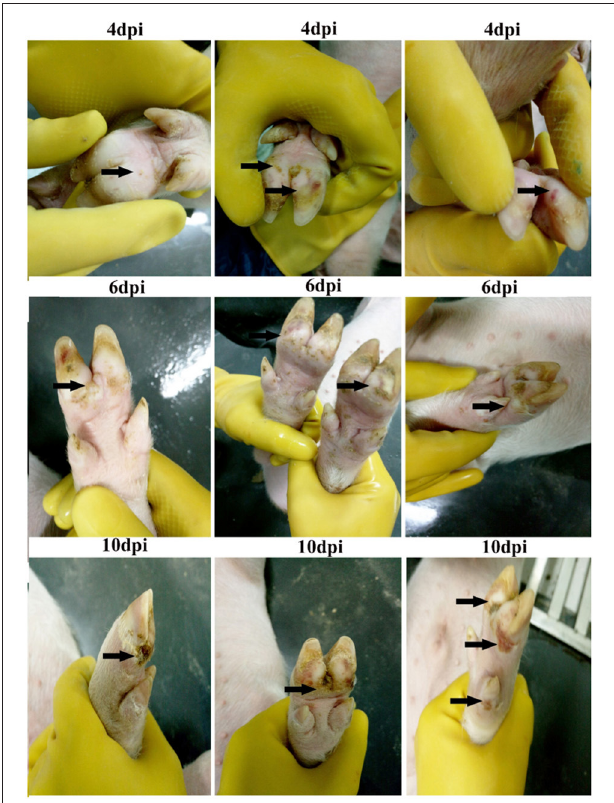
FIGURE 2 | Progression of Senecavirus A (SVA)-induced vesicular disease on hooves. Red spots were firstly observed on hooves [4 days post-infection (dpi)] and then rapidly developed into fluid-filled vesicles (6 dpi). Finally, the vesicles ruptured and left ulcerated lesions on the